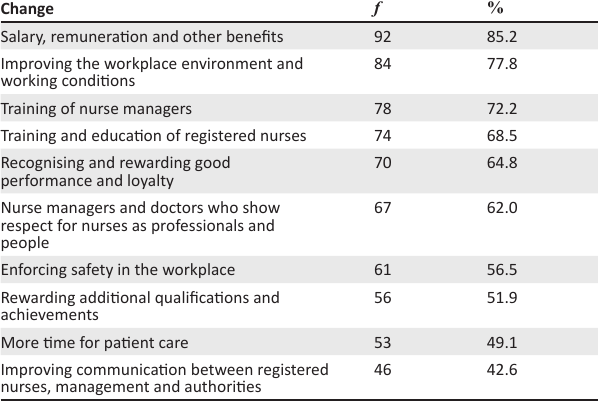
TABLE 1: Changes that would enhance registered nurses’ retention ( n =